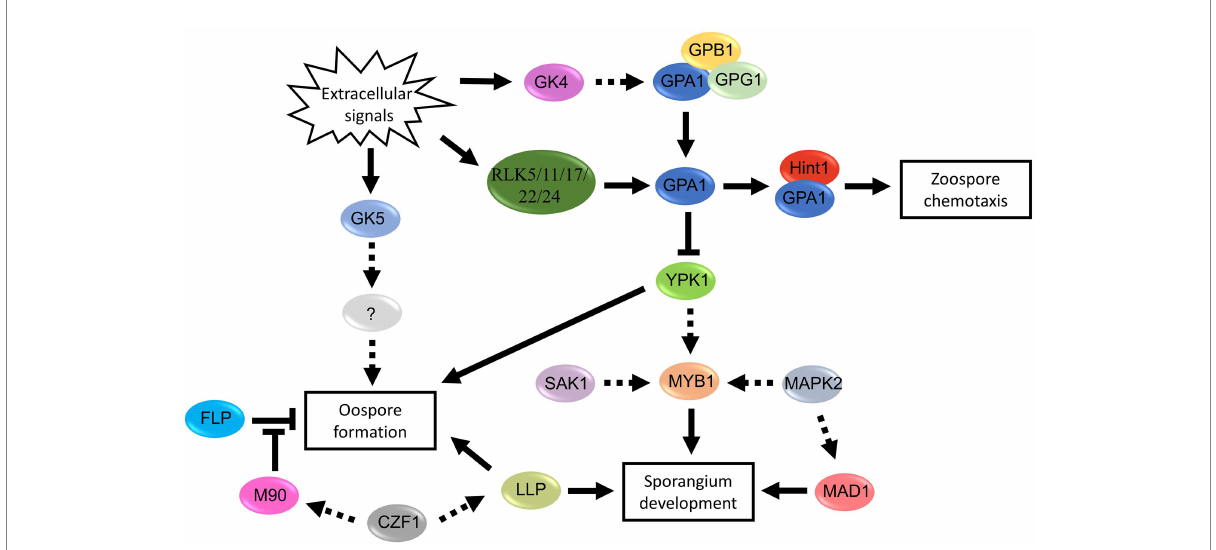
FIGURE 5 Proposed signal pathways involved in spore development of Phytophthora and Peronophythora . Arrows with solid line represent direct positive regulation, arrows with dotted line represent potential positive regulation and T-line represent negative